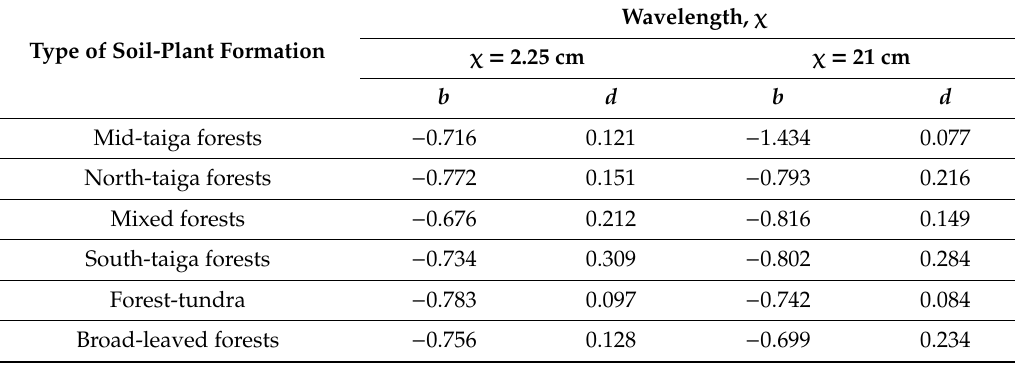
Table 4. Description of weighted coe ffi cients values in Equation